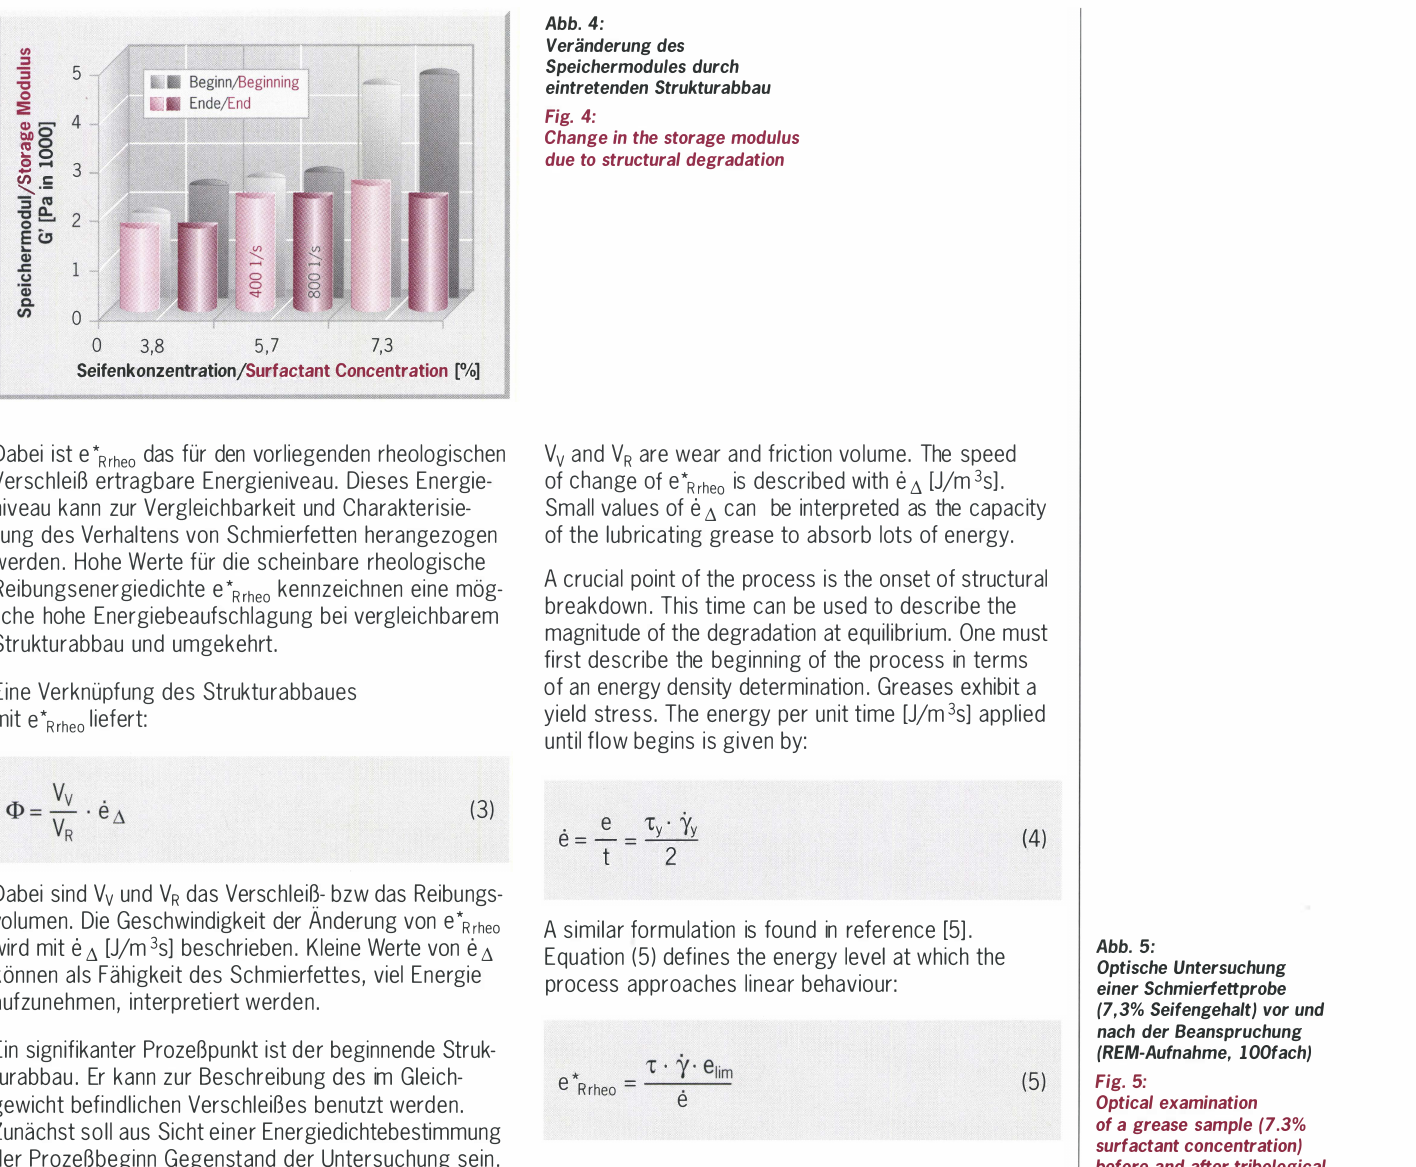
of a grease sample (7.3% surfactant concentration} before and after tribological loading (Scanning